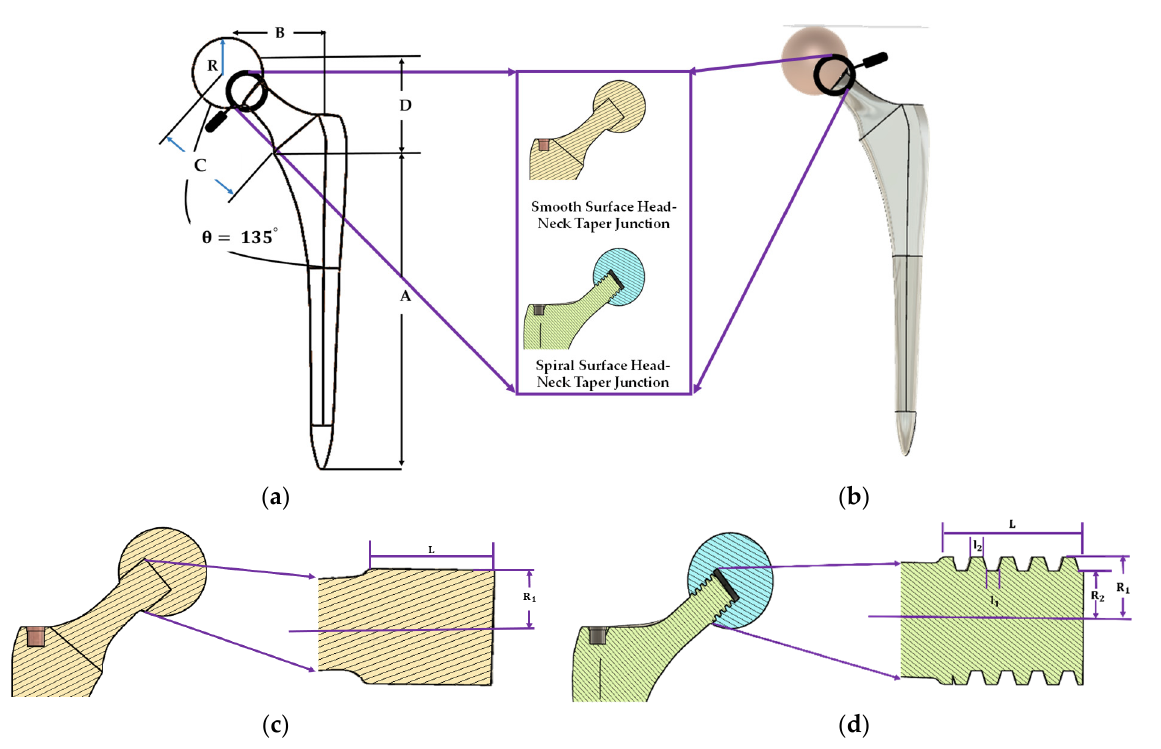
Figure 2. Illustration of a ( a ) 2D and ( b ) 3D geometrical view of the hip implant body and inner geometry of ( c ) smooth surface and ( d ) spiral surface of head-stem trunnion. Table 2. Geometrical parameters values of the hip implant body and head-stem trunnion.